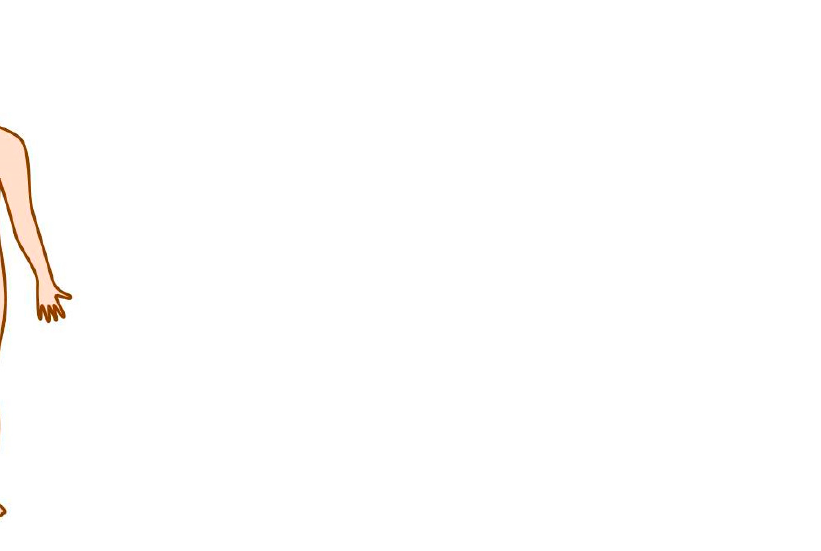
Figure 14. Life cycle of Onchocerca volvus . The patient is infected by a blood meal from a blackfly belonging to the genus Similium . The nematode (worm) is situated in nodules in the skin. The male nematode is up to 5 cm and the female nematode up to 70 cm long. The female worms produce a number of microfilariae, which cause the symptoms [88,89]. Like in the case of malaria transmission is performed by an insect.